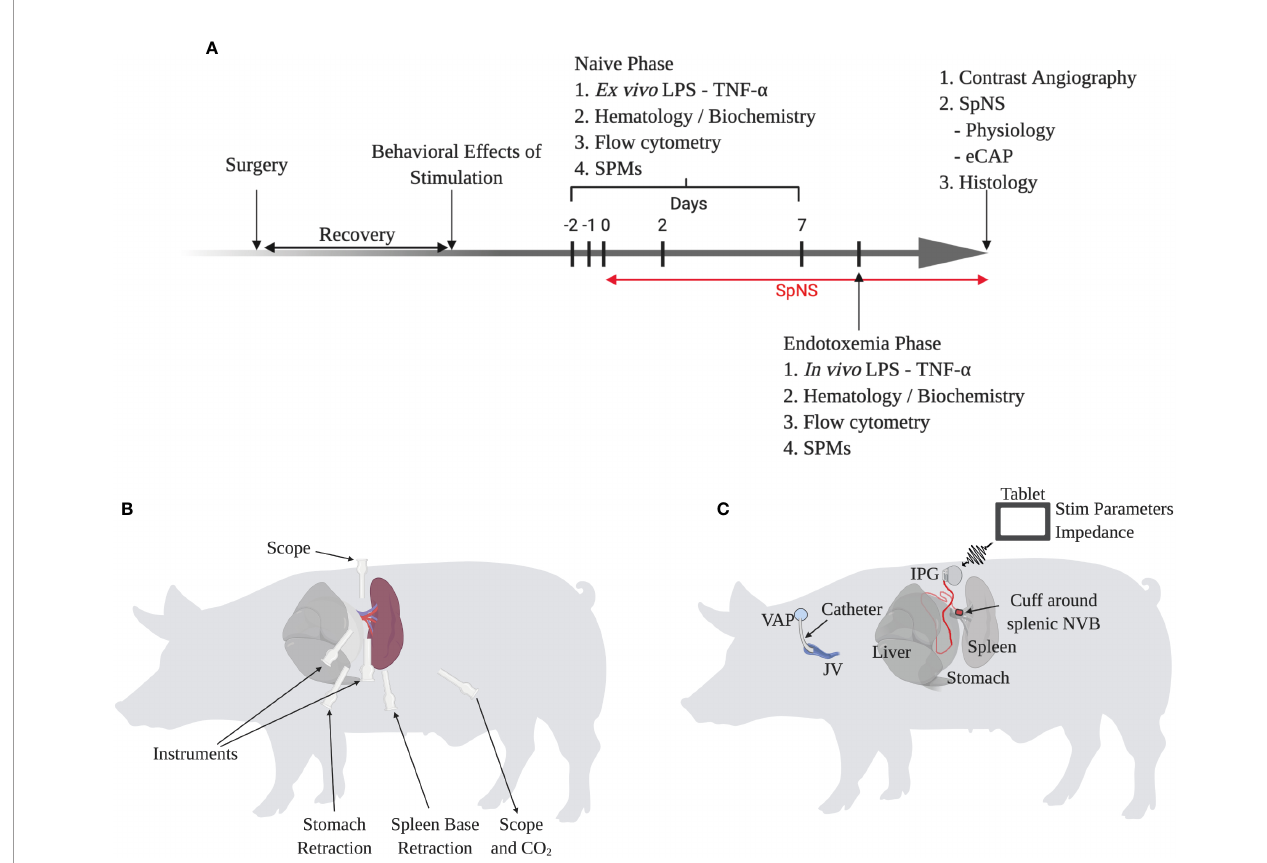
FIGURE 3 | Chronic Conscious Neuromodulation Study Methods and Re fi nement of the Minimally-Invasive Surgical Implantation Procedure. (A) Schematic of overall chronic conscious study design. Each phase is described in more detail in the methods and supplementary information. (B) Schematic of surgical implantation procedure showing trocar position and use, relative to the spleen. (C) Schematic of chronic neuromodulation and blood sampling procedure. Animals were implanted with a catheter in the jugular vein and a circumferential cuff electrode around the splenic neurovascular bundle (NVB) connected to an implantable pulse generator (IPG). The IPG was wirelessly controlled by a tablet to control stimulation parameters and measure